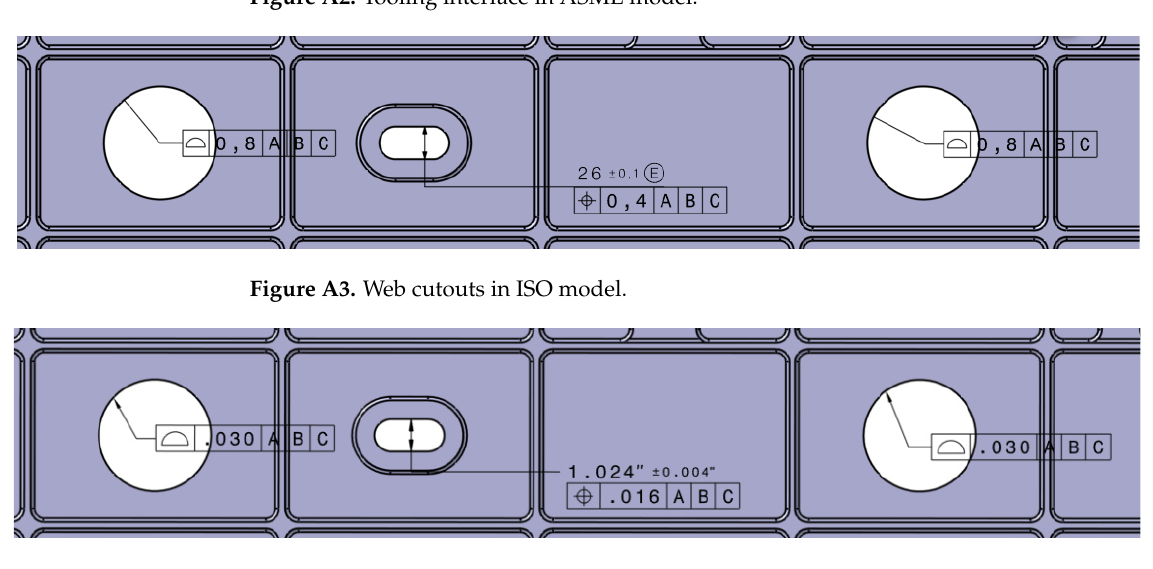
Figure A4. Web cutouts in ASME model.